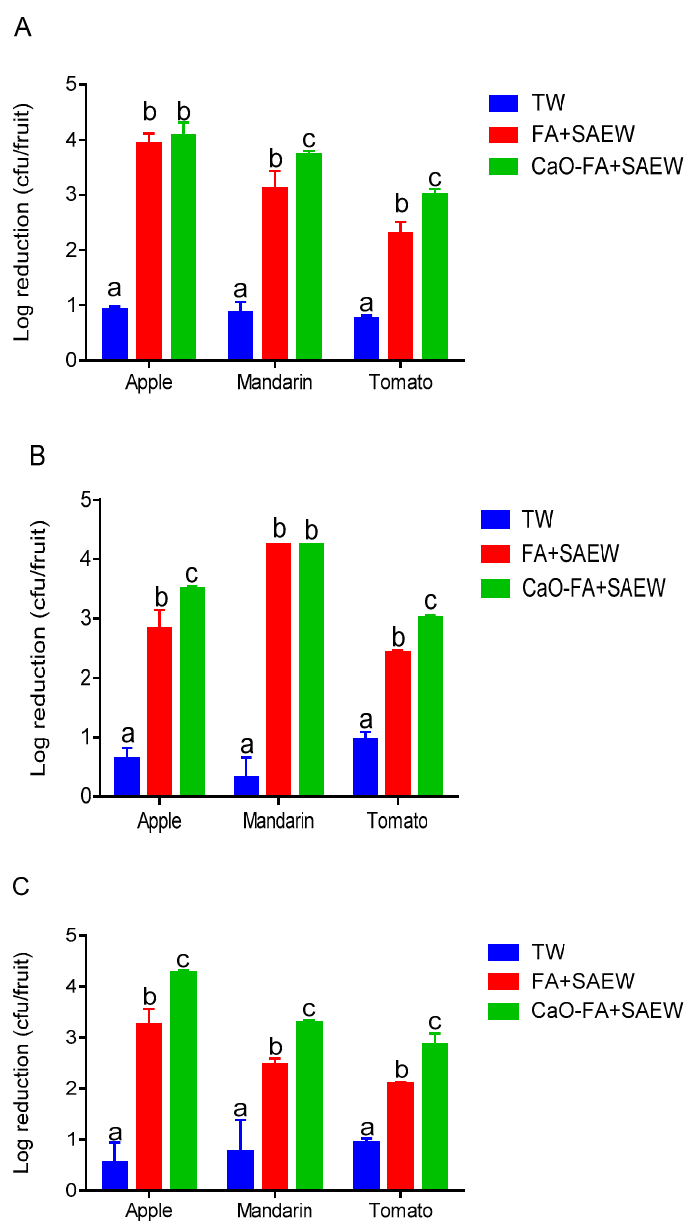
Figure 2. Natural microbiota reduction on different fresh fruits washed with tap water (TW), fumaric acid combined with SAEW (FA + SAEW), and calcium oxide followed by combination (CaO-FA + SAEW). ( A ) Total aerobic bacteria; ( B ) total coliforms; ( C ) yeast and mold. Vertical bars represent standard error of the mean ( n = 3), different letters in the same group indicate a significant ( p < 0.05) treatment effect.